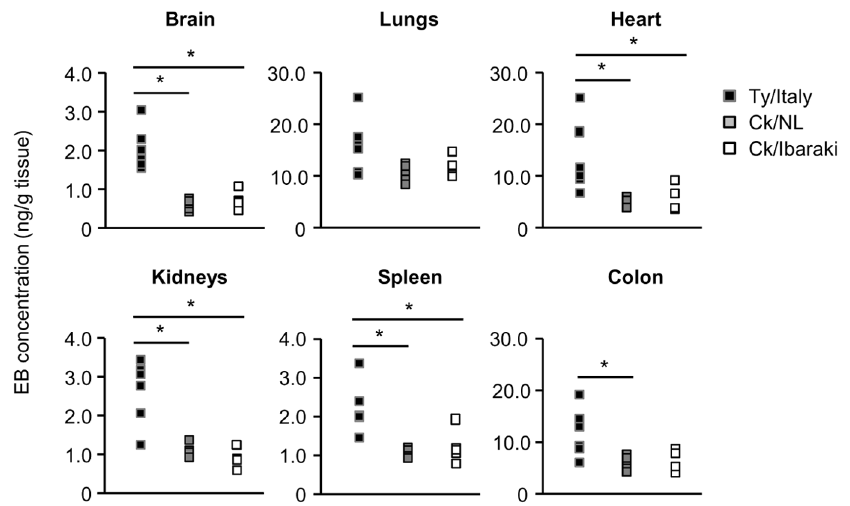
Figure 7. EB concentrations in the tissues of individual chickens. Values from the chickens inoculated with Ty/Italy (n = 6), Ck/NL (n = 5), and Ck/Ibaraki (n = 5) are shown with closed squares, gray squares, and open squares, respectively. The asterisk indicates a significant difference between 2 groups (P <